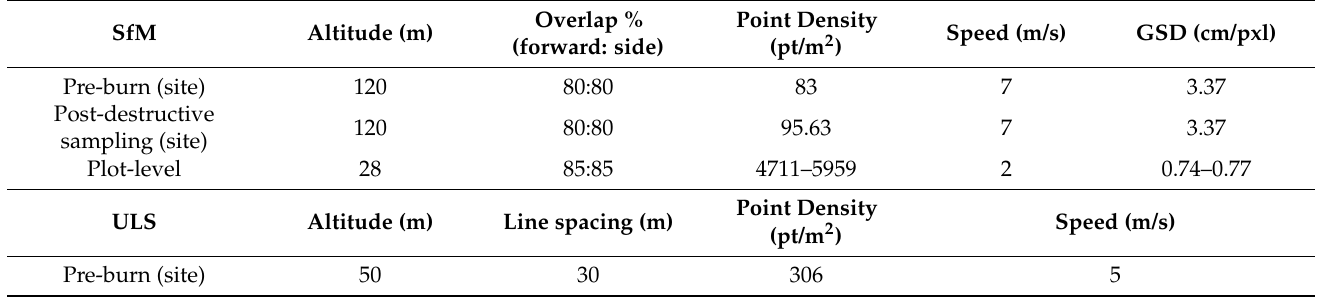
Table 2. Flight parameters and data resolution statistics for UAV data